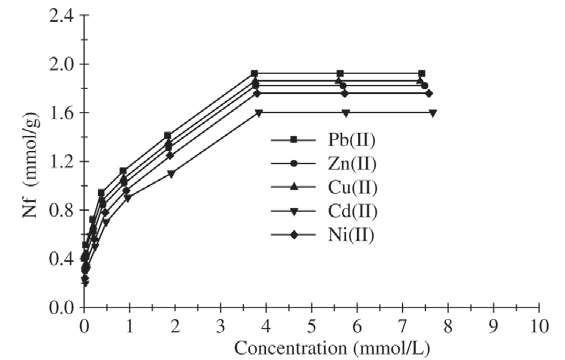
Figure 4. Exchange equilibrium of Cu(II), Cd(II), Ni(II), Pb(II) and Zn(II), respectively, between Cell-PAB and aqueous solution at room temperature.